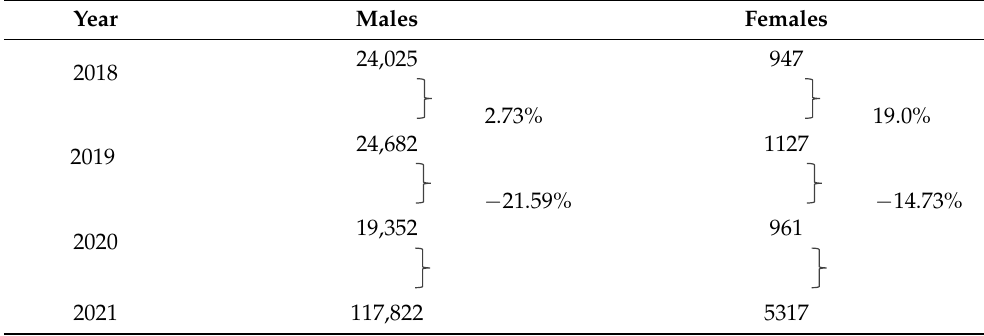
Table 1. Women’s involvement in drug abuse from 2018–2021.